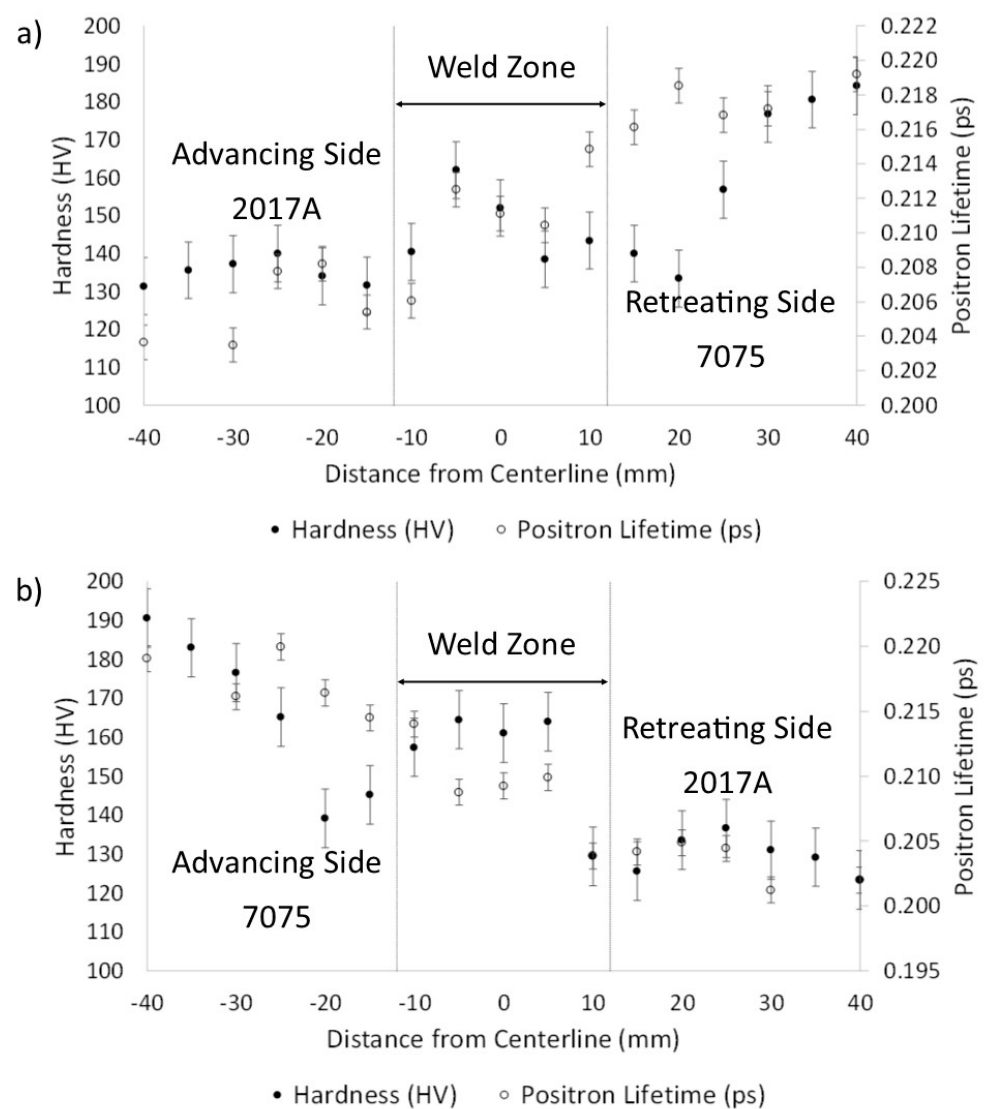
Figure 4. Positron lifetime curves superimposed on average hardness profiles highlighting the correlation between the characterization methods: ( a ) AS 2017A/RS 7075 and ( b ) AS 7075/RS 2017A.